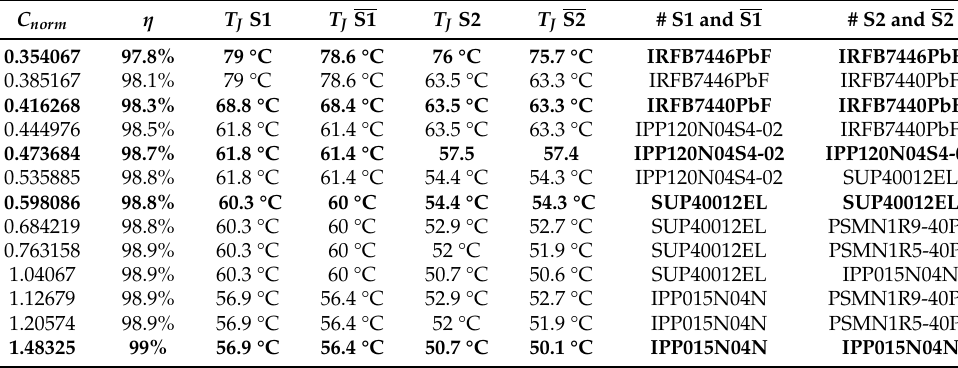
Table 8. Design details for DSPLS with 800